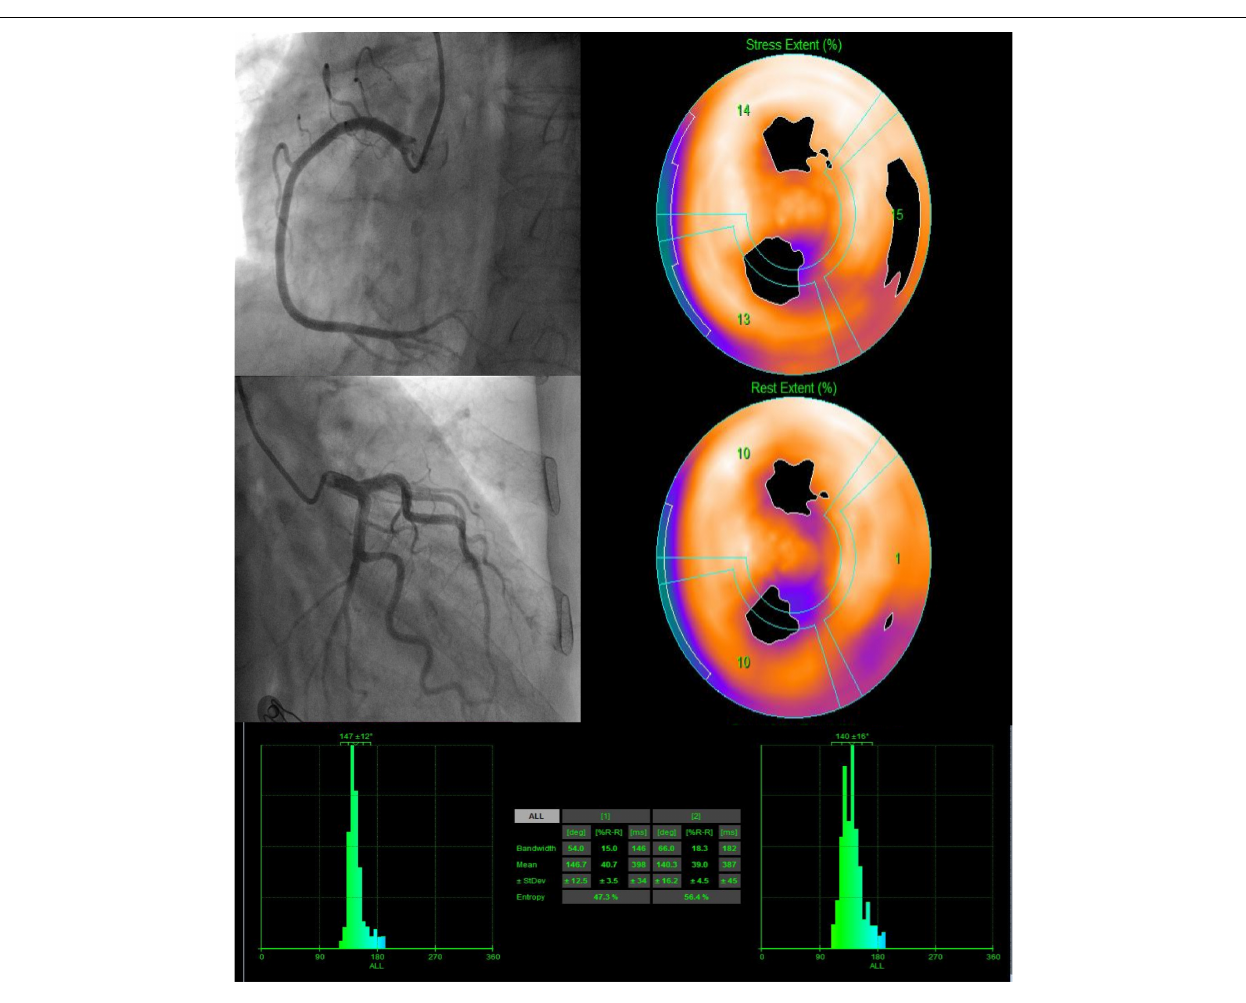
Frontiers in Cardiovascular Medicine |